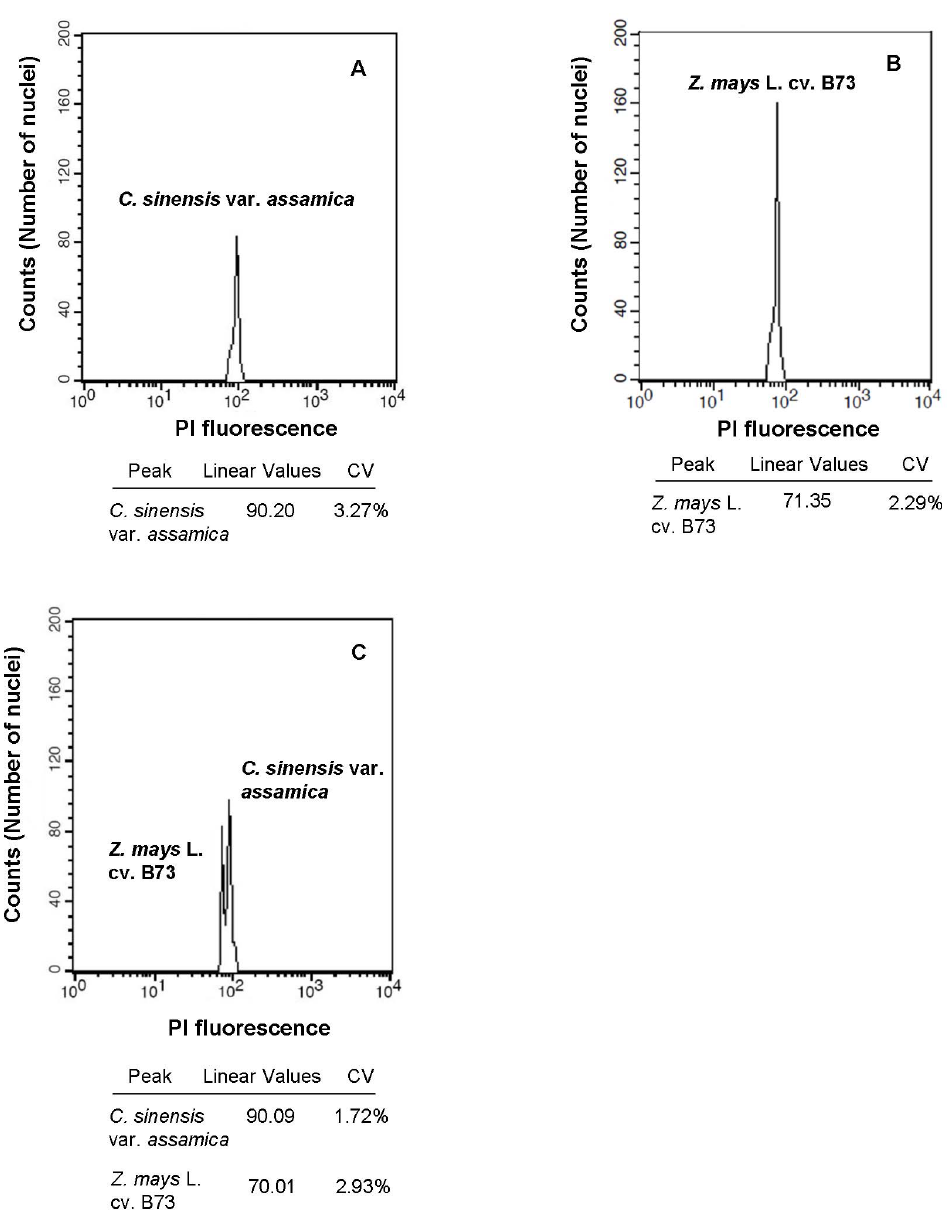
Figure 1. Cytogram of fluorescence intensity of C.sinensis var. assamica and Z.mays L. cv. B73 nuclei isolated with an improved WPB buffer. Leaves of C. sinensis var. assamica and Z. mays that were treated individually (a, b) or simultaneously processed (co-chopped) (c), and stained with PI. X: Relative fluorescence; Y: Number of nuclei.